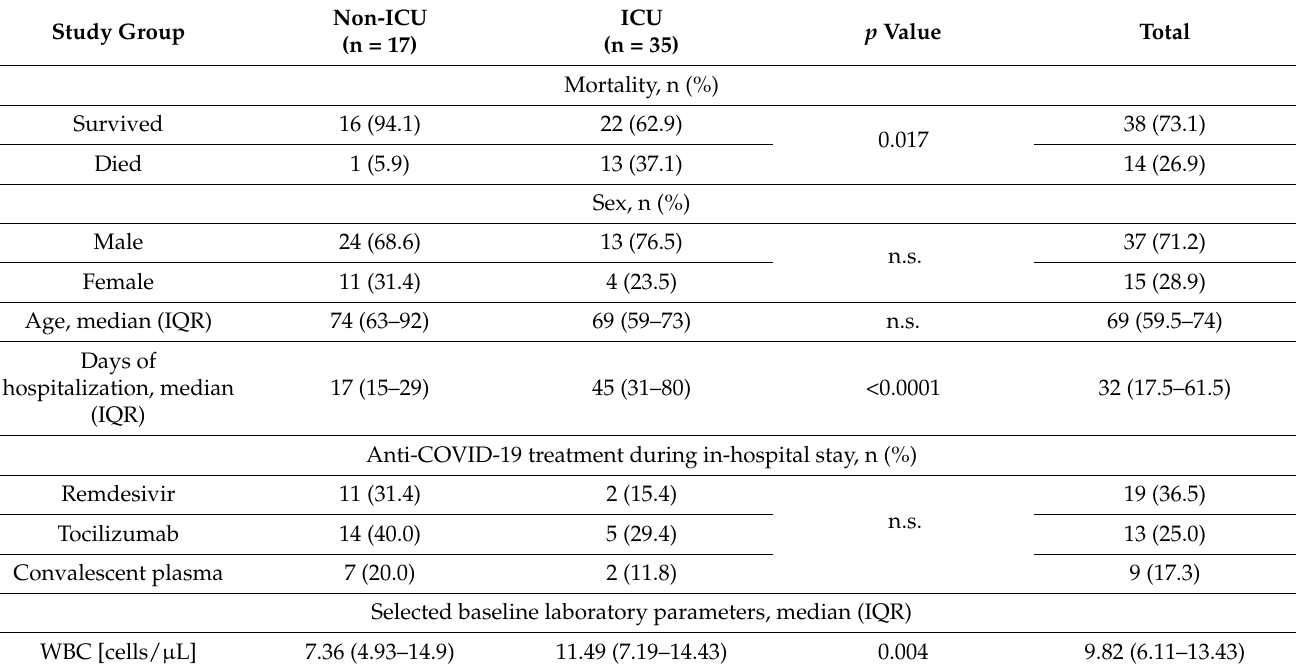
Table 1. Clinical and baseline laboratory characteristics of the analysed patient